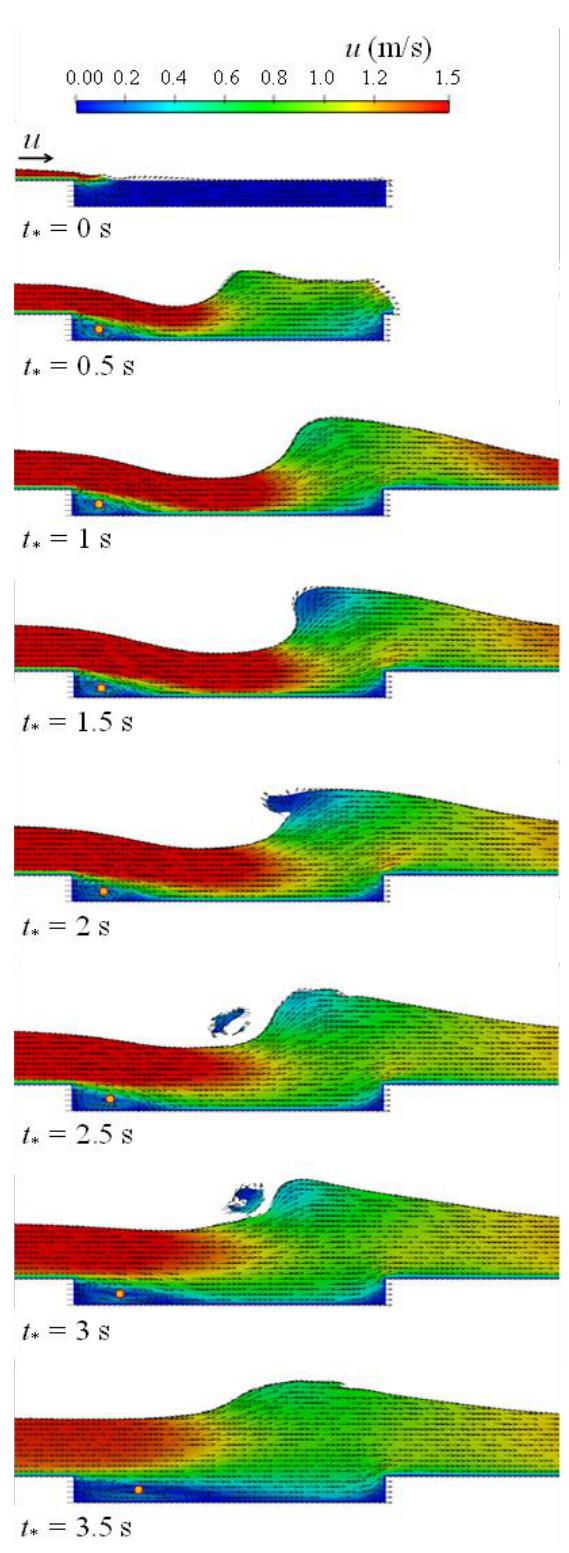
Figure 10. Variations of the contour plots of velocity and velocity vector fields with time, for a bore from an impoundment with a depth of d o = 0.3 m, passing over a canal with a width of w = 0.6 m and a depth of d = 0.05 m. The dots in the contour plots show the eye of the vortex.